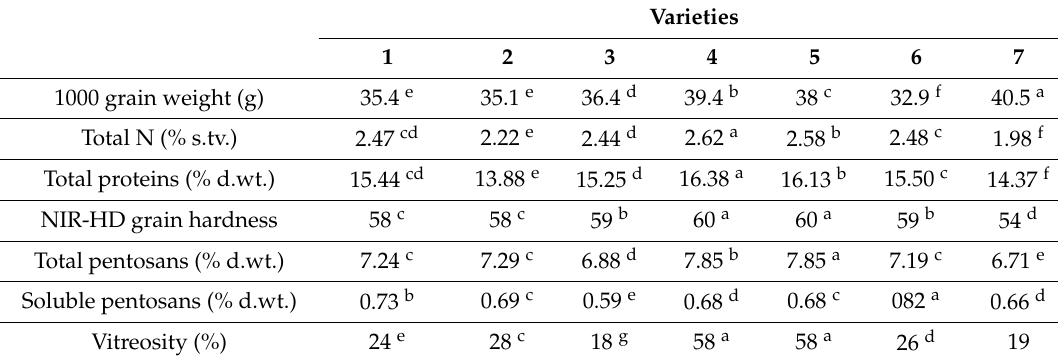
Table 1. Results of the wheat analysis.